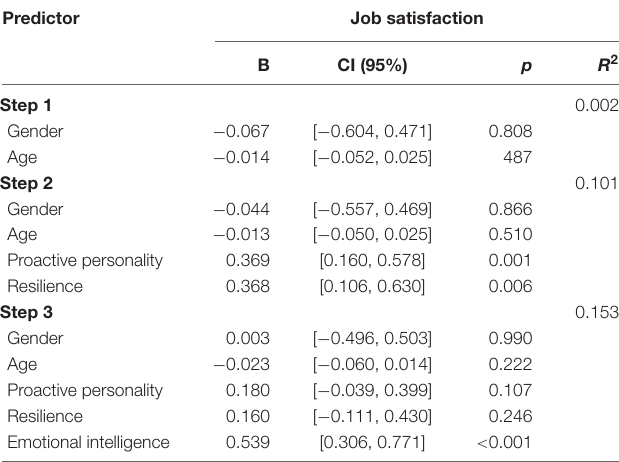
TABLE 2 | Summary of the hierarchical regression analysis with job satisfaction as the criterion